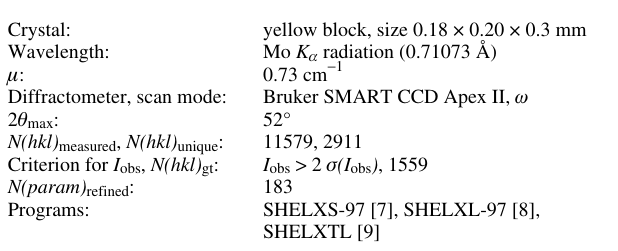
Table 1. Data collection and handling.